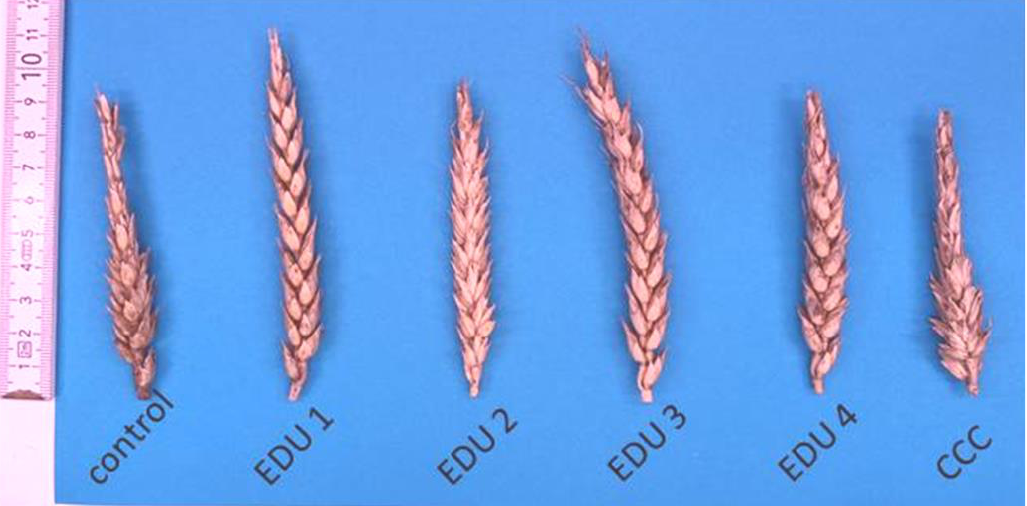
Figure 3. Type of ear shape for different compounds.